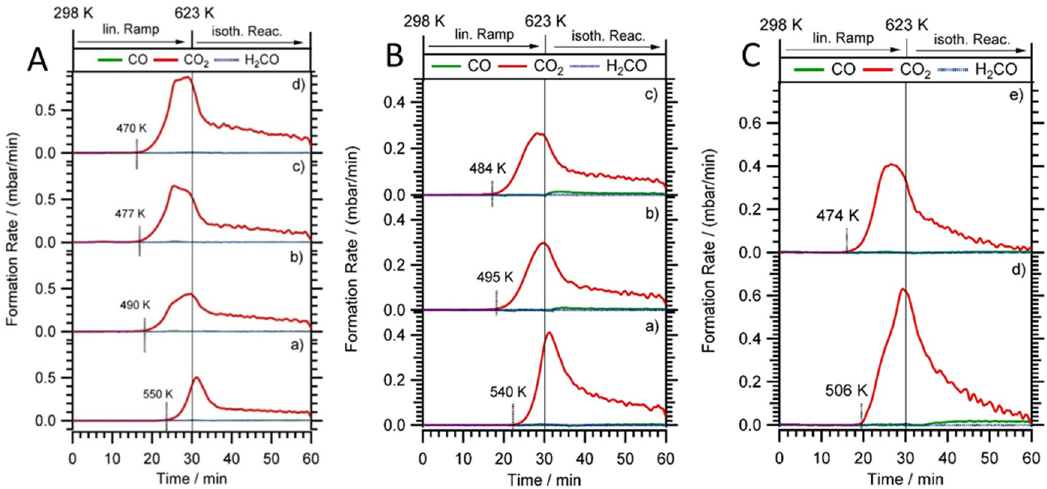
Figure 8. Methanol steam reforming on the initial Cu ‐ Zr metal ‐ intermetallic compound catalysts. ( A ) Cu:Zr stoichiometry = 2:1, ( a – d ) four subsequent runs on the same starting material. Note that the decrease of CO 2 formation rate during the isothermal reaction is due to progressive reactant consumption (methanol conversion after 60 min ~100% for ( d )). ( B ) Catalysis data: ( a ) for run 1; ( b ) for run 2; and ( c ) for run 3 on a Cu/Zr catalyst with the initial ratio Cu:Zr = 9:2. ( C ) ( d , e ) runs 1 and 3 for an initial ratio Cu:Zr = 1:2.